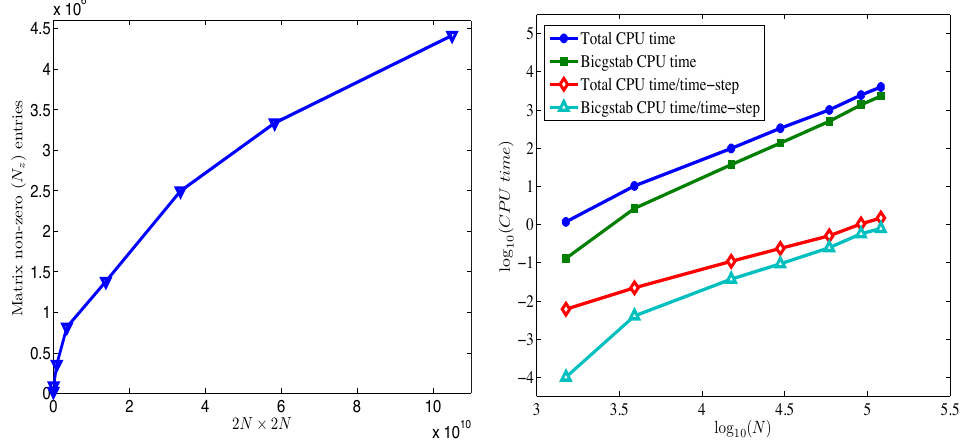
Figure 14. Non-zero elements as a function of N ( left ) and CPU times as a function of N ( right